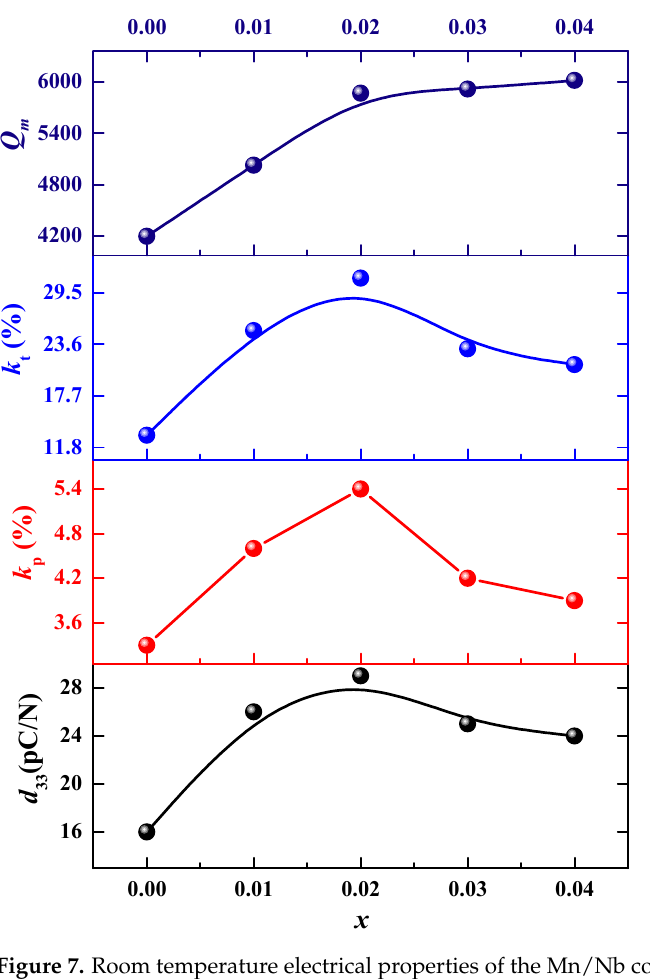
Figure 7. Room temperature electrical properties of the Mn/Nb co-doped NBT.